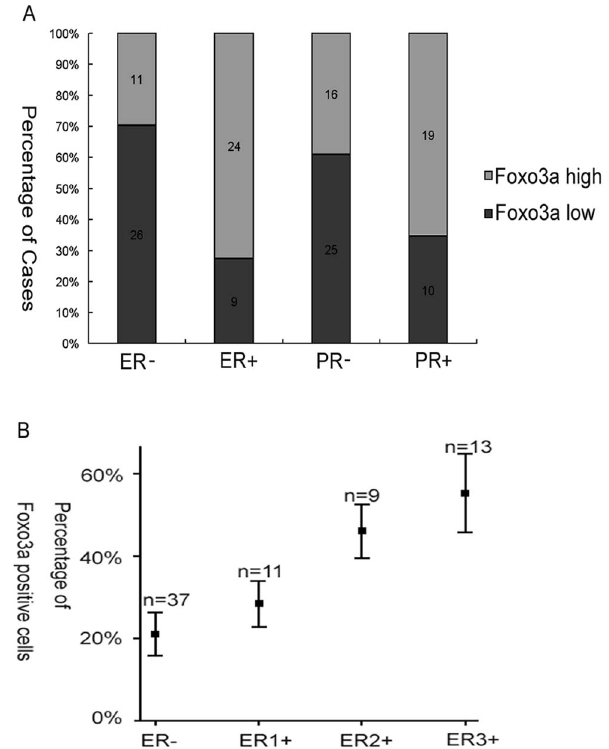
Figure 3. Foxo3a expression correlated with hormone receptor positivity. (A) The number of Foxo3a-positive cases was dispropor- tionally higher in ER 2 positive (24) and PR-positive (19) cases compared with ER-negative (11) and PR-negative cases (16, P , 0.001). (B) Similarly, there was a direct correlation between the percentage of Foxo3a- positive cells per case and the intensity of ER staining (P , 0.001).